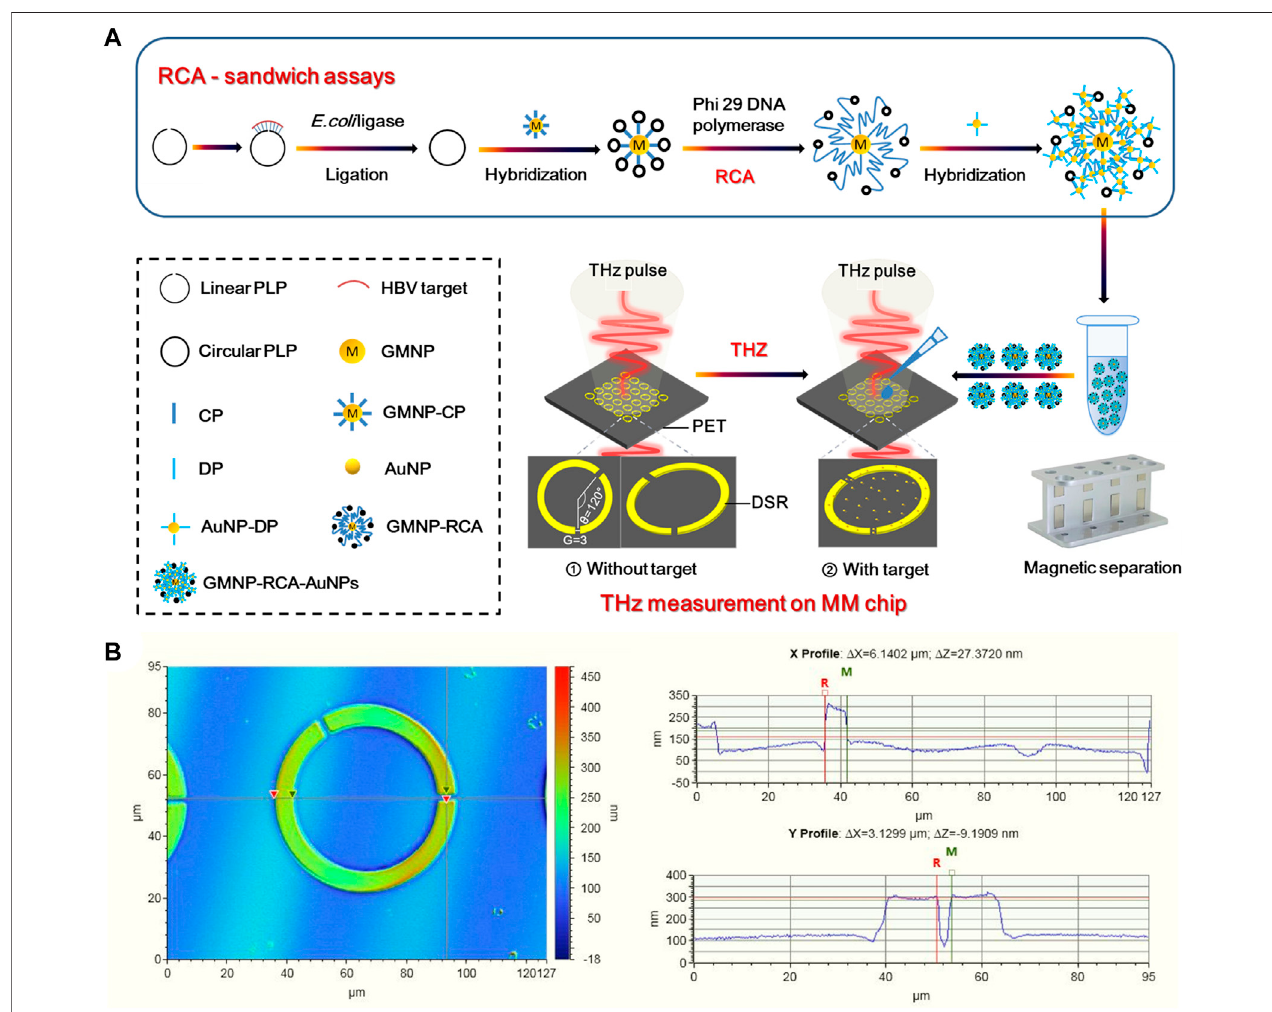
FIGURE 1 | THz biosensing strategy for HBV DNA detection. (A) Schematic description of the THz MM biosensor chip for HBV DNA detection based on the GMNPs-RCA-AuNPs sandwich assay. (B) Characterization of DSR cell in a square lattice with dimensions of width and (G).